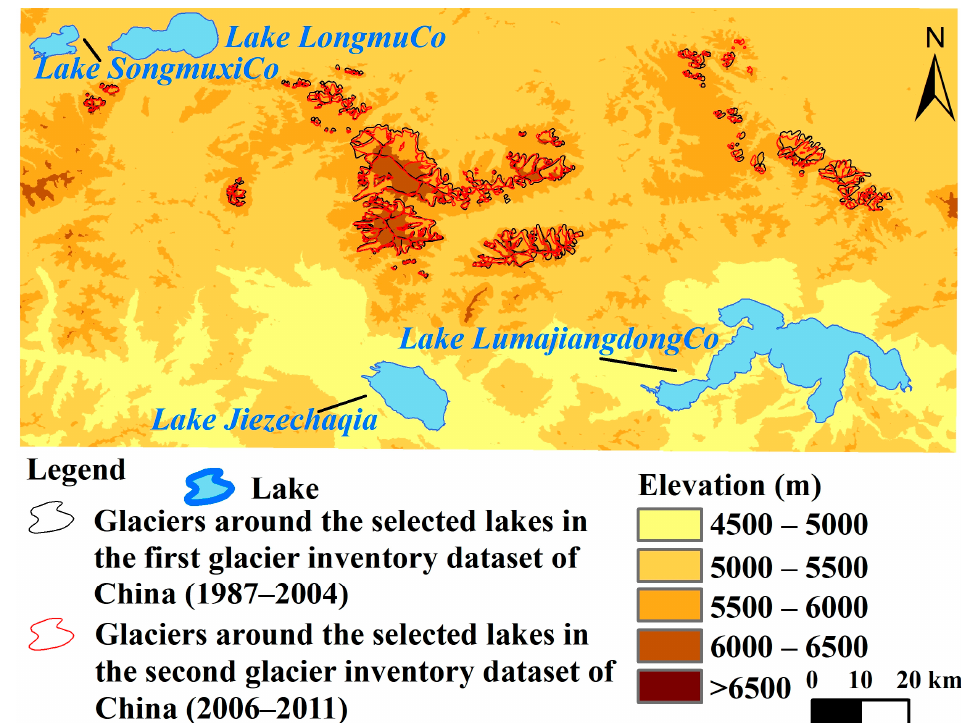
Figure 5. Area changes of glaciers around Lake LongmuCo and Lake Jiezechaqia.